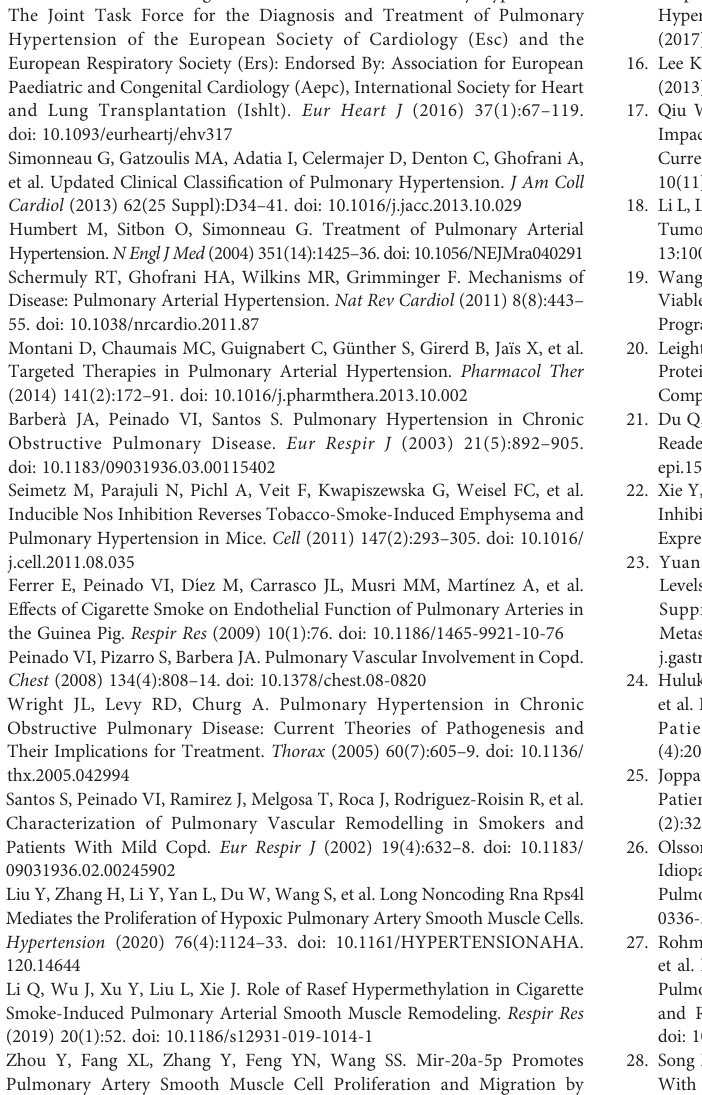
Supplementary Figure 2 | MBD2 mRNA elevated after CSE stimulation. Quantitation of the MBD2 gene ’ s mRNA expression after 2% CSE stimulation for 24h. The data are presented as mean ± SD, n=3. *** P < 0.001.